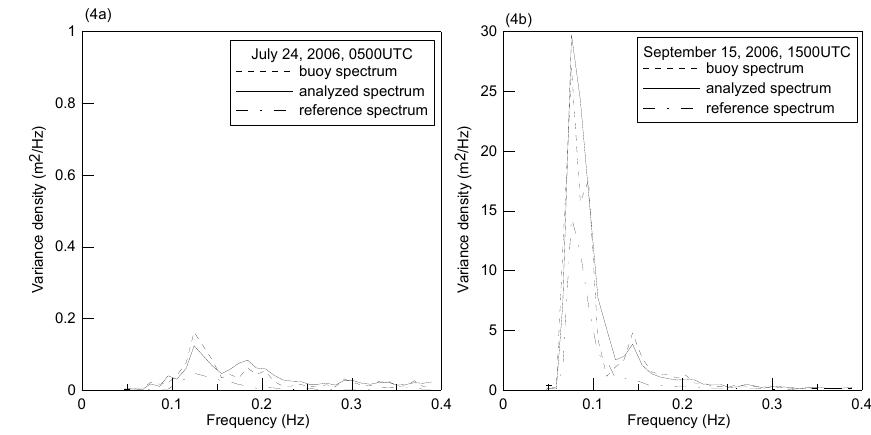
(c) Fig. 3. Directional wave spectra at the Hualien buoy on 26 July 2006 at 0500 UTC: (a) buoy observation, (b) assimilation run, and (c) reference run.